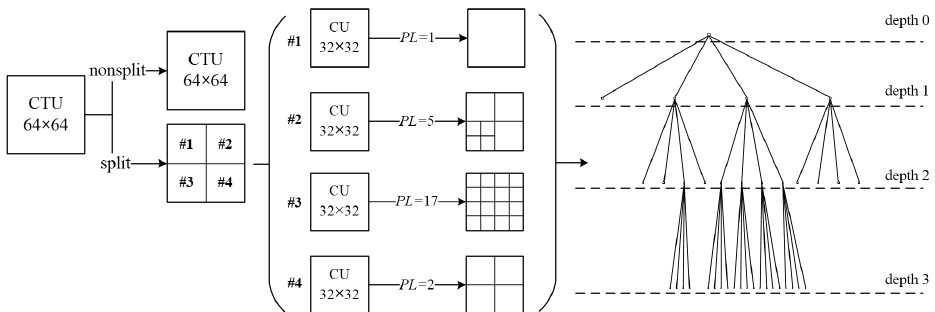
Figure 6. An example of CTU partition structure determination process with the corresponding partition quad-tree. PL is the predicted label for a 32 × 32 CU output by ResNet. PL is set as an integer from 1 to